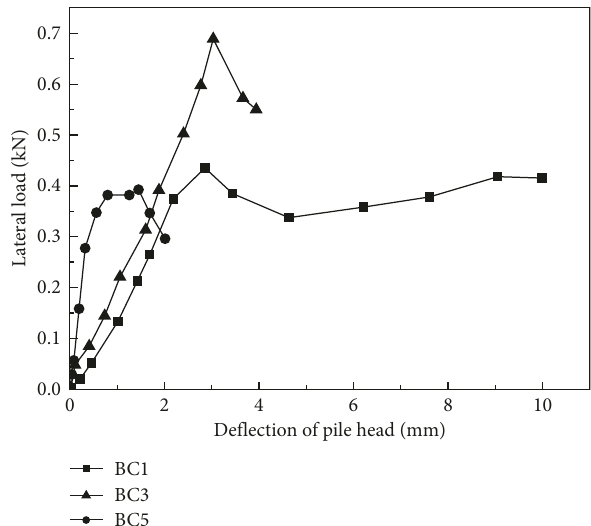
Figure 16: Load-deflection curve of rock-socketed piles with steel- retaining tube.